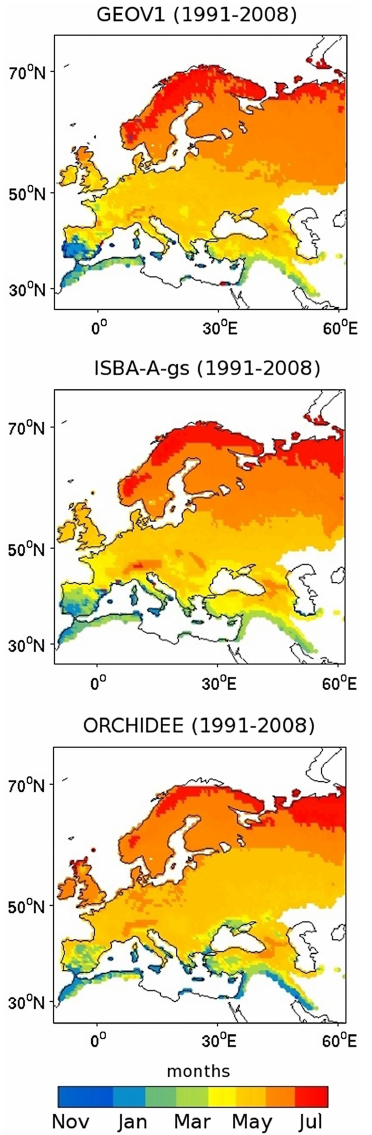
Figure 6. Mean simulated leaf onset values derived from the (top) GEOV1 LAI satellite-derived product and (middle) ISBA-A-gs LAI, and (bottom) ORCHIDEE LAI. The period used to produce the mean vegetation annual cycle is 1991–2008 for the three data sets.